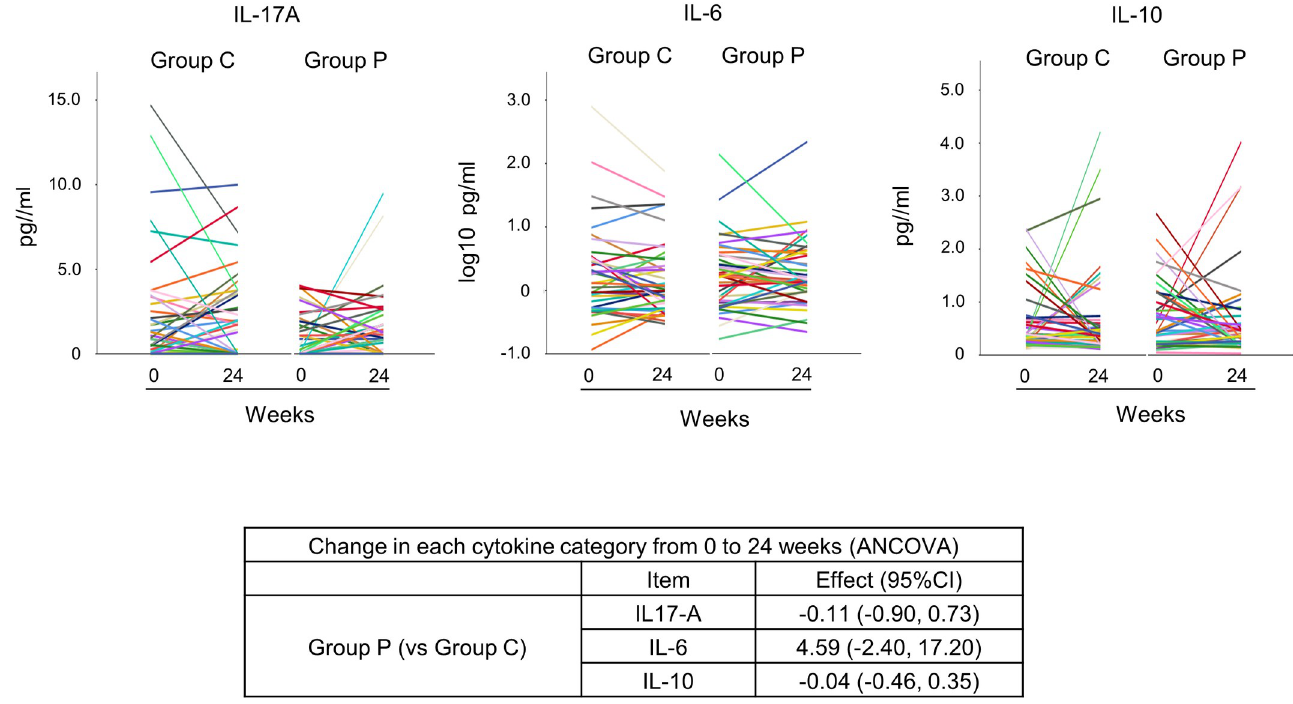
Fig 4. Changes in cytokines over the course of the study in the FAS. Bootstrap confidence intervals are calculated because the normality of the residuals is problematic (repeated 1000 times). The IL-6 value is shown as a log10 value due to the large variability of values. ANCOVA; analysis of covariance, C, control; CI, confidence interval; IL, interleukin; P,